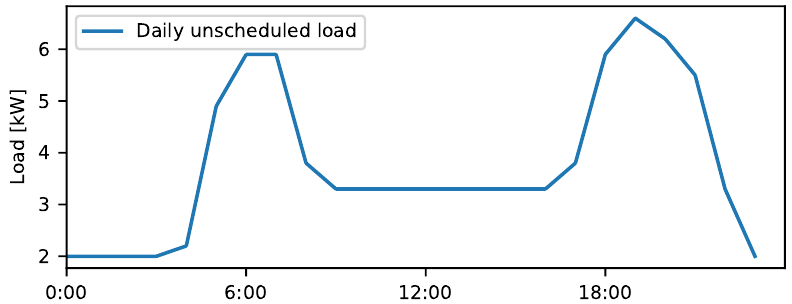
Figure 5. Unscheduled load profile of the industrial campus.